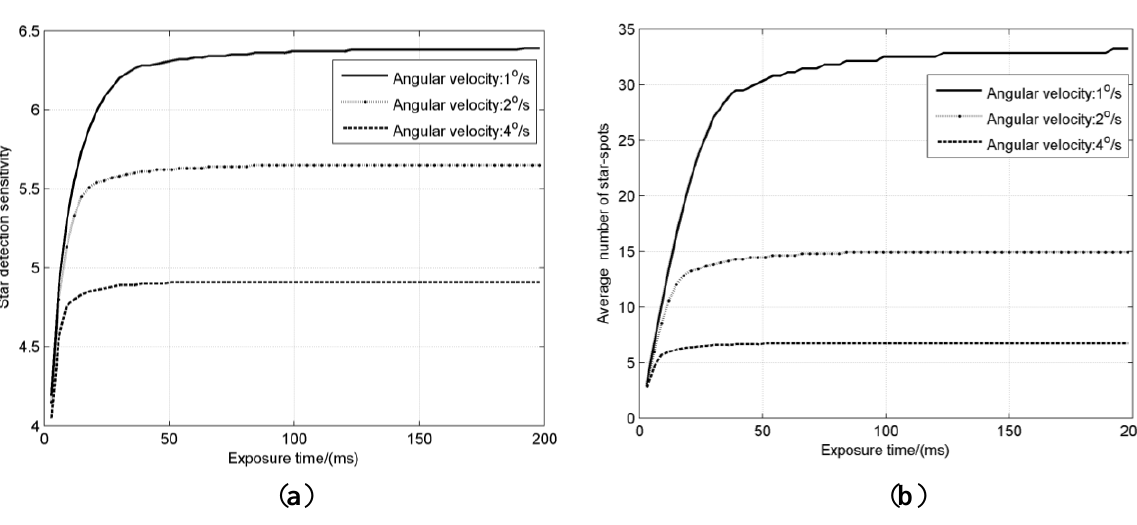
Figure 4. ( a ) Star detection sensitivity Mv with different exposure times; ( b ) The average number of star-spots N with different exposure times. star